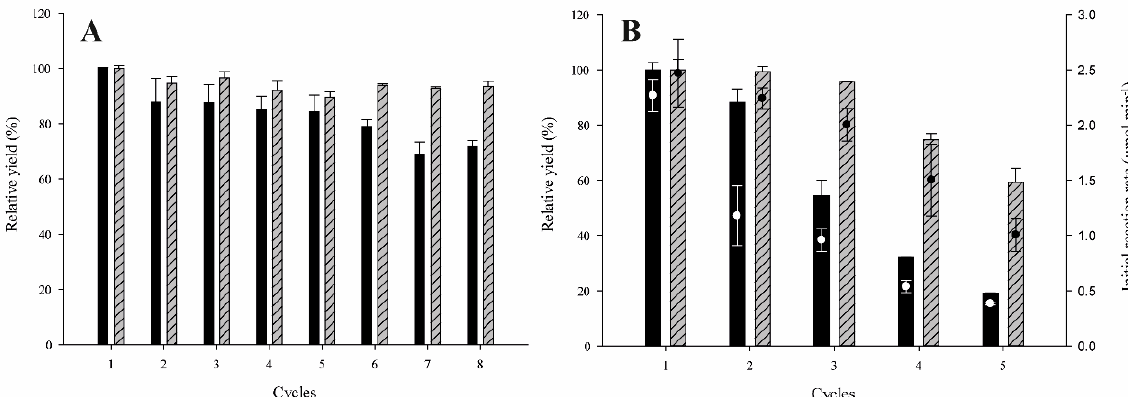
Figure 3. ( A ) Relative yield of consecutive transesterification runs with each biocatalyst as obtained by following the 1-pulse ethanol addition procedure. ( B ) Relative yield of consecutive esterification reactions of each biocatalyst as obtained with butyric acid and ethanol as substrates. EB-rROL (black) and EB-proROL (striped grey). The final yield of the first run was taken to be 100%.